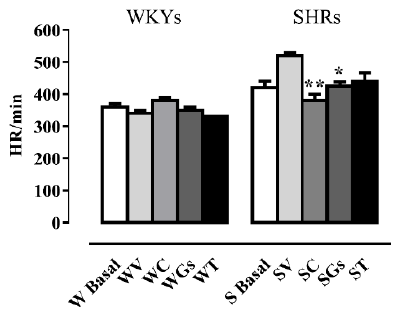
Figure 3. Effect of different treatments on heart rate (HR) in SHRs and WKYs. Rats were treated for 4 weeks with vehicle, captopril (50 mg/kg), tomatine (8 mg/kg) and gel/serum (12.40 g/kg). Data reported